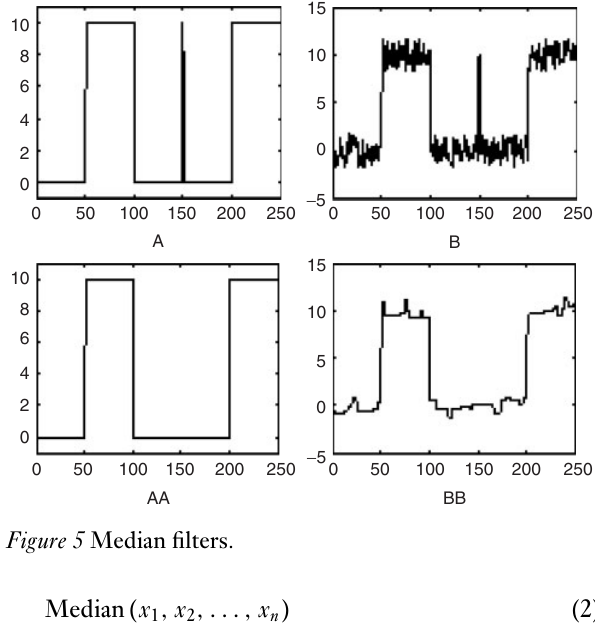
Figure 5 Median